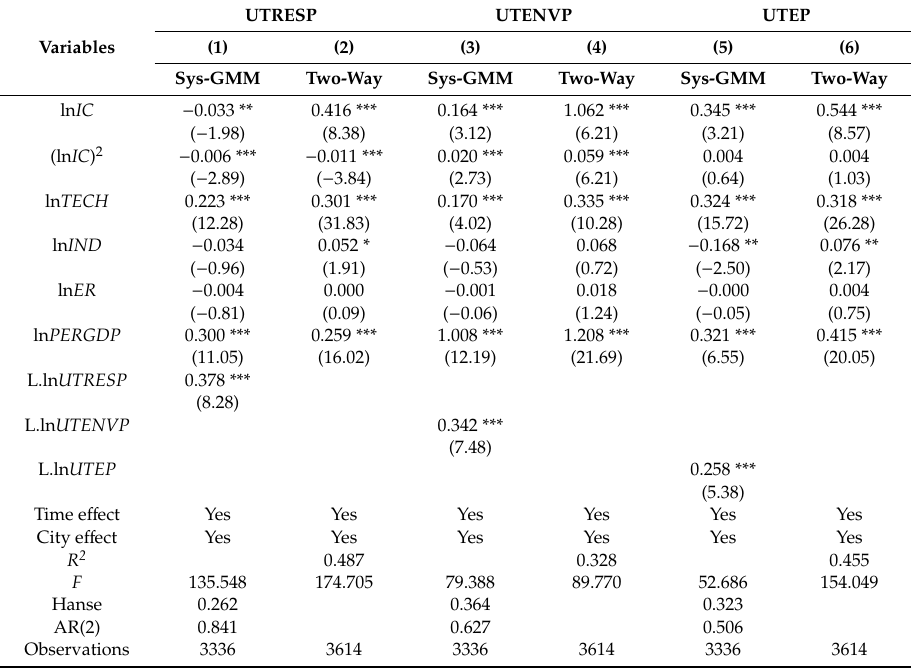
Table A2. Robust analysis of basic estimated